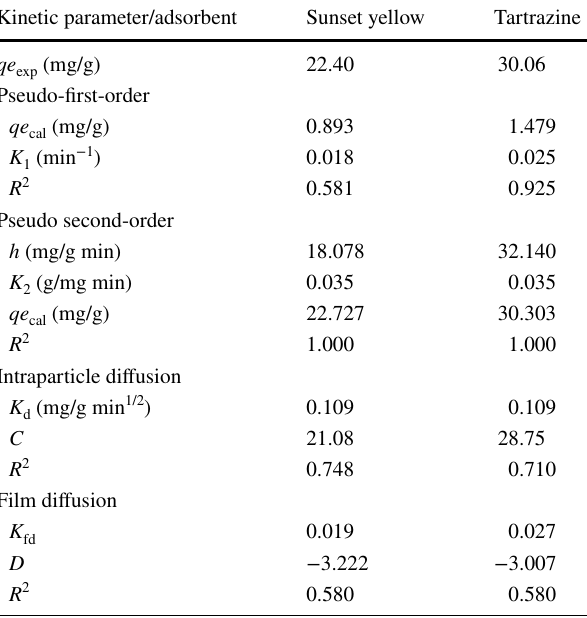
Table 3 Kinetic model constants for the uptake of sunset yellow and tatrazine dye onto